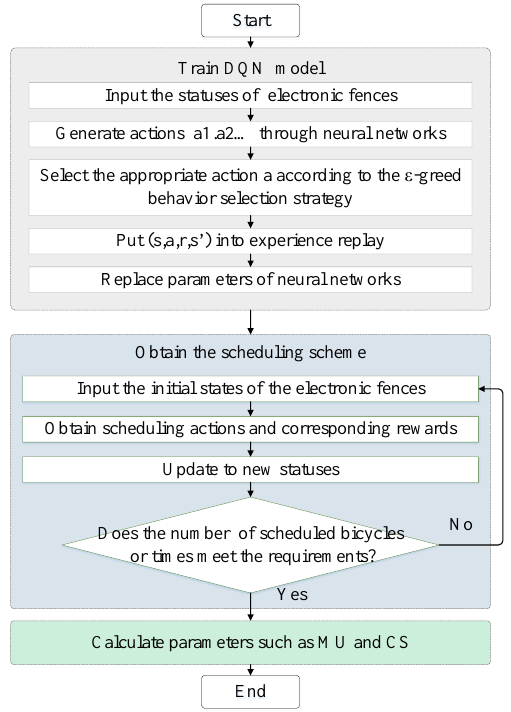
Figure 4. Optimization process of electric fence scheduling.